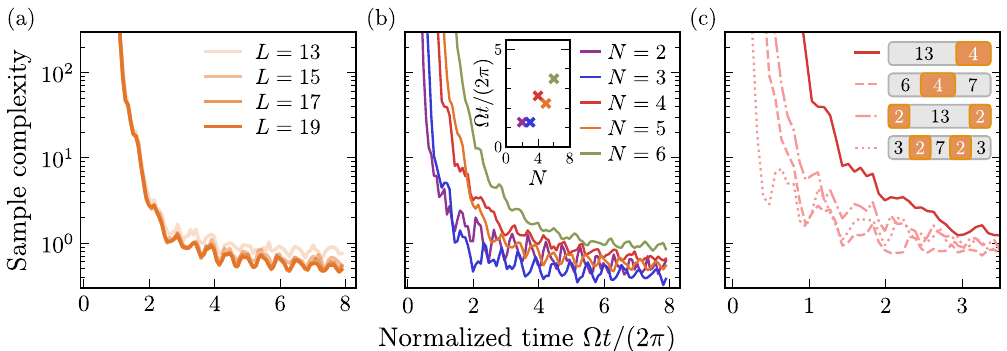
FIG. 9. Effects of the Lieb-Robinson bound on the sample complexity of our scheme. In all examples, we simulate quench evolving a one-dimensional chain of system and ancilla Rydberg atoms, and we plot the sample complexity of estimating the state fidelity with our protocol. (a) We simulate the quench evolution of a one-dimensional chain of total length L and N ¼ 5 Rydberg atoms as the system of interest. Increasing the length of the chain does not significantly change the sample complexity of our protocol against time: at early times, the sample complexity is high since most of the information about the state is contained in the Lieb-Robinson light cone. At late times, information has spread into enough ancillary degrees of freedom and the sample complexity does not significantly improve from spreading into more ancillas. (b) Larger system sizes N require longer times for the sample complexity to saturate: we attribute this to the time taken for the Lieb-Robinson light cone to encompass a sufficient number of (approximately N ) ancillary atoms. In the inset we observe an approximately linear scaling by plotting the earliest time that the sample complexity is below 1.5, as a function of system size N . Here, we fix the total system size to be L ¼ 17 . (c) The rate of information spreading can be varied by changing the position of system atoms: the sample complexity saturates at different times, decreasing when the number of boundaries between system and ancilla atoms are increased from one to four